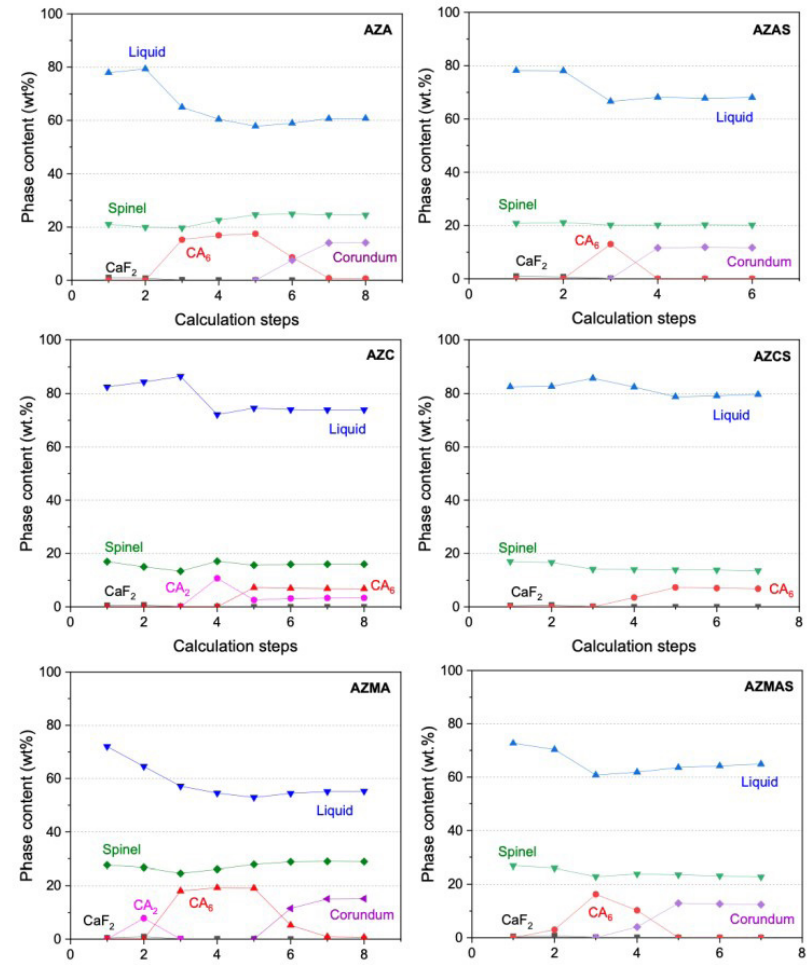
Figure 6. Predicted phases obtained via thermodynamic calculations for the interaction between the silica-free castables (AZA, AZC and AZMA) and the silica-containing ones (AZAS, AZCS and AZMAS) with a synthetic slag at 1500 °C and pressure = 1